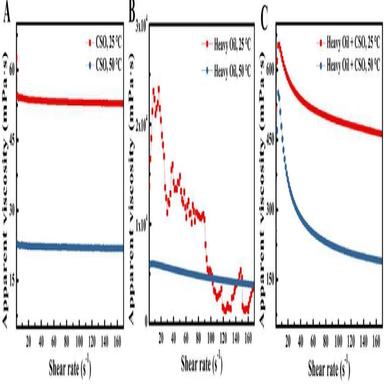
Apparent viscosity as a function of shear rate of (A) CSO, (B) heavy oil, and (C) heavy oil þ CSO (1:1) at 25 C and 50 C. CSO, cottonseed oil.